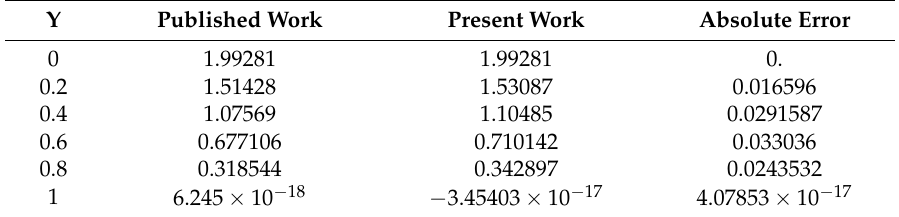
Table 2. The numerical comparison of the present work and published work [22] with absolute